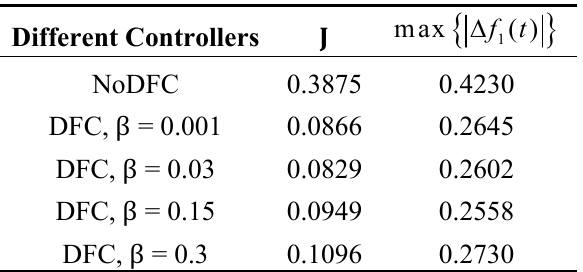
Table 4. Theperformance index using different controller parameters with a short-circuit fault disturbance ( α = 20).